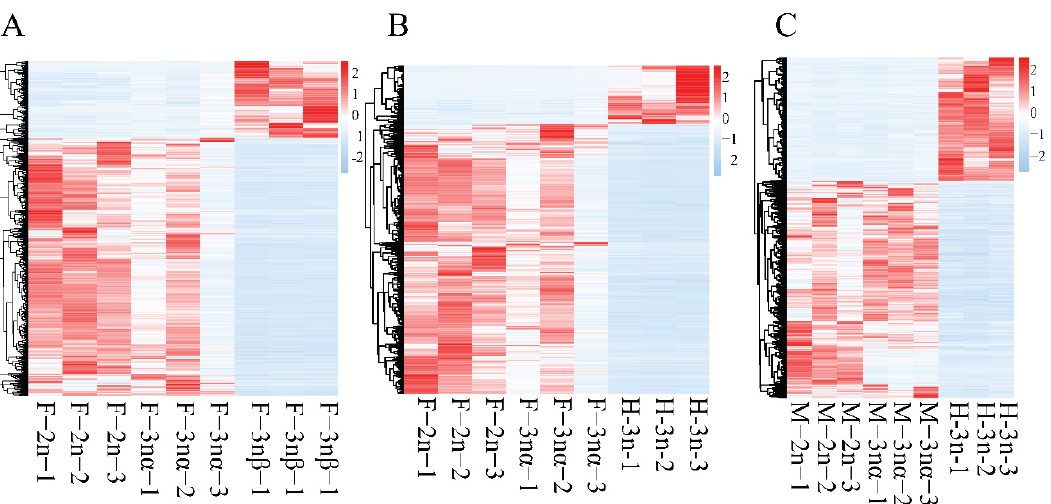
Figure 3. Transcript patterns of DEGs in F-3n β group ( A ), HF-3n group ( B ), and HM-3n group ( C ) are presented in heatmaps. Red indicates relatively high expression, while blue indicates relatively low expression among samples.